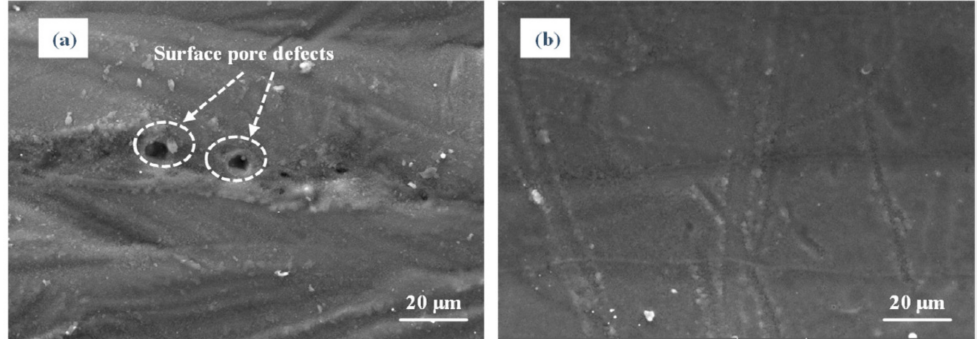
Figure 15. SEM images of the surface pore defects. ( a ) surface without treatment. ( b ) polished surface. (Reprinted with permission from ref. [126]. Copyright 2021, open access).